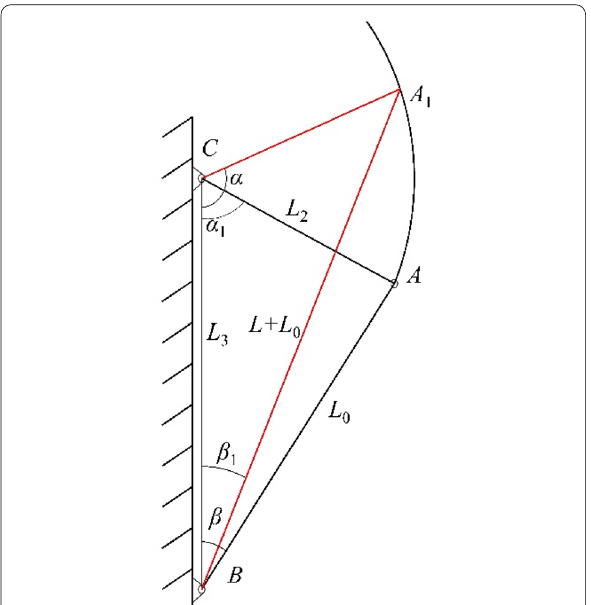
Figure 4 Kinematic analysis of lifting mechanism